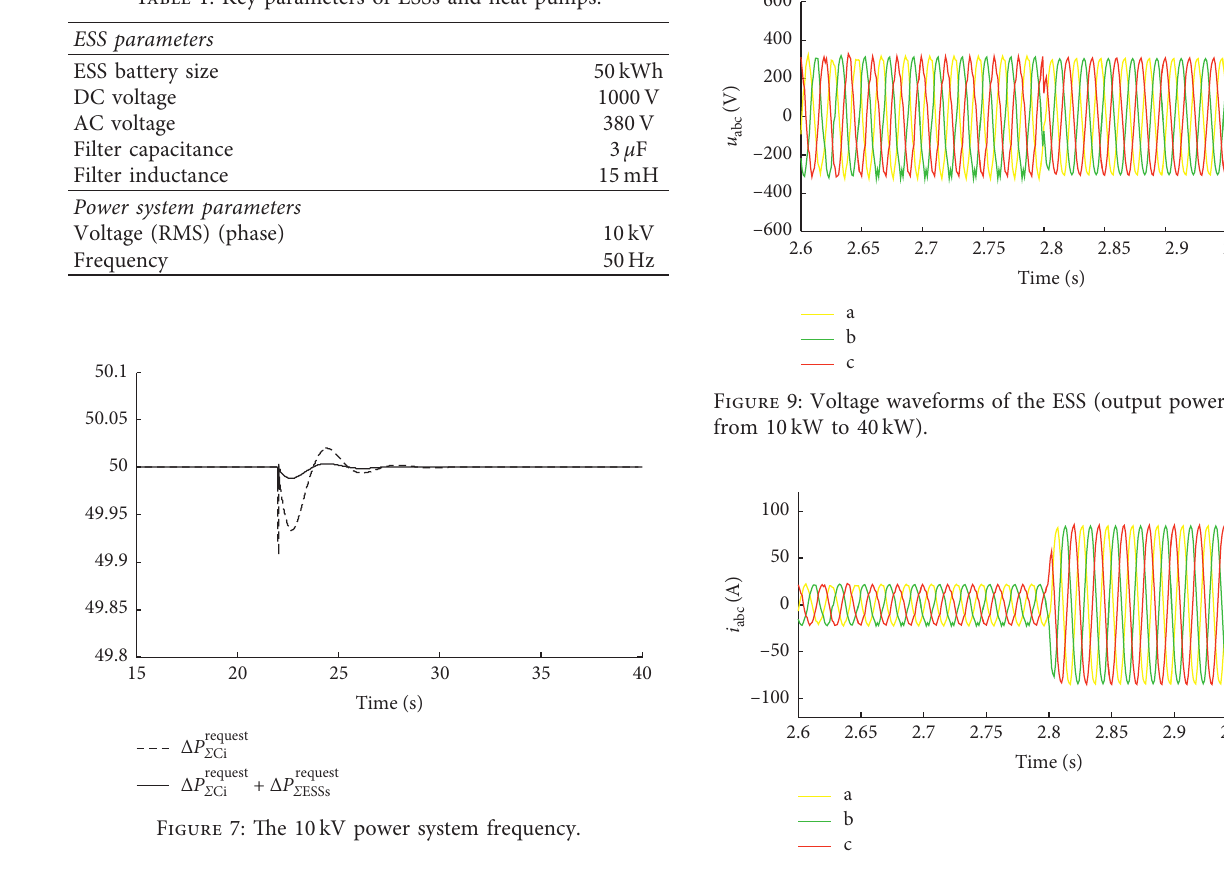
Figure 10: Current waveforms of the ESS (output power increases from 10kW to